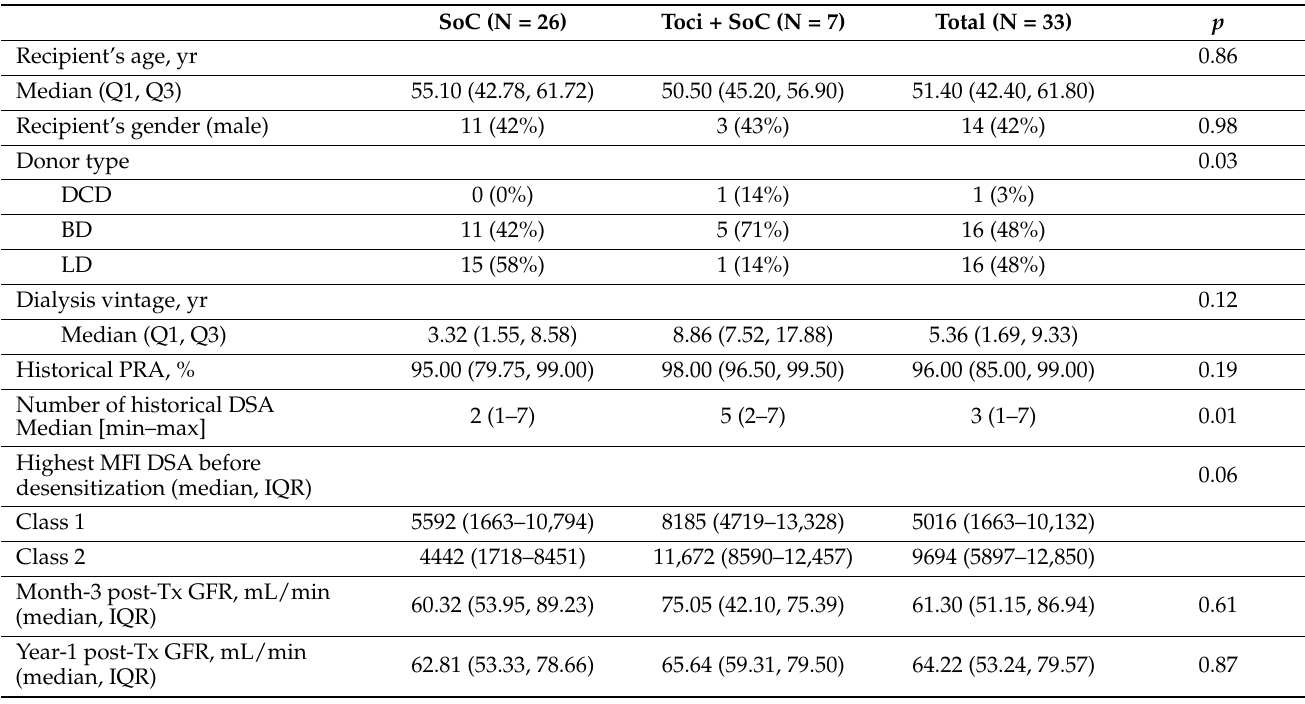
Table 1. Demographic characteristics of the study